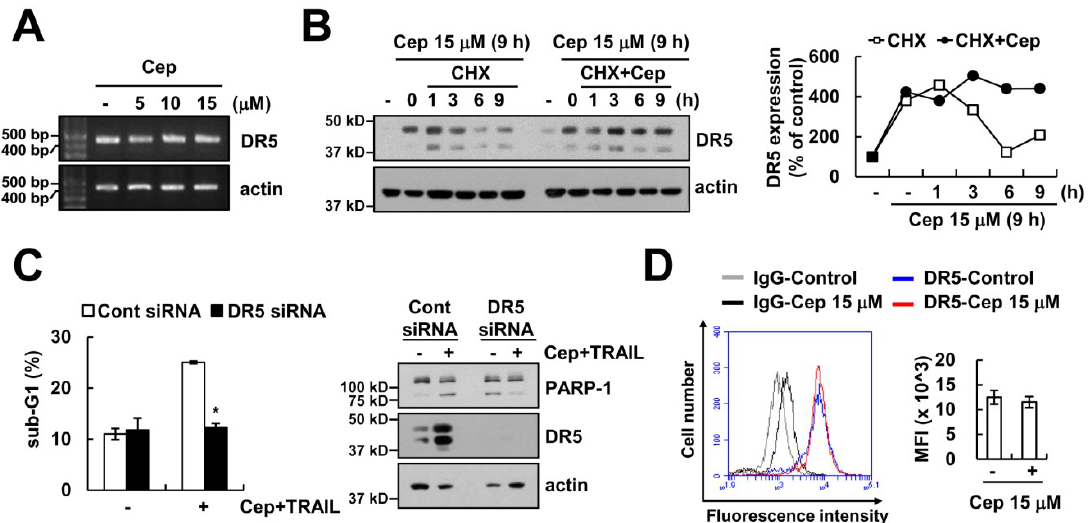
Figure 2. CEP increased DR5 protein expression in the cytosol, but not in the cell surface. ( A ) Caki cells were treated with 5–15 μM CEP for 18 h. DR5 and actin mRNA expression were analyzed by RT- PCR; ( B ) Caki cells were treated with 15 μM CEP for 9 h, and then washed with PBS. After washing, cells were treated with 20 ng/mL cycloheximide (CHX) with or without of 15 μM CEP for 1–9 h The DR5 and actin expression was detected by Western blot ( left panel ). The public domain JAVA image- processing program ImageJ was used for measuring band intensity of DR5 protein ( right panel ); ( C ) Caki cells were transfected control or DR5 siRNA, and then cells were treated with 15 μM CEP